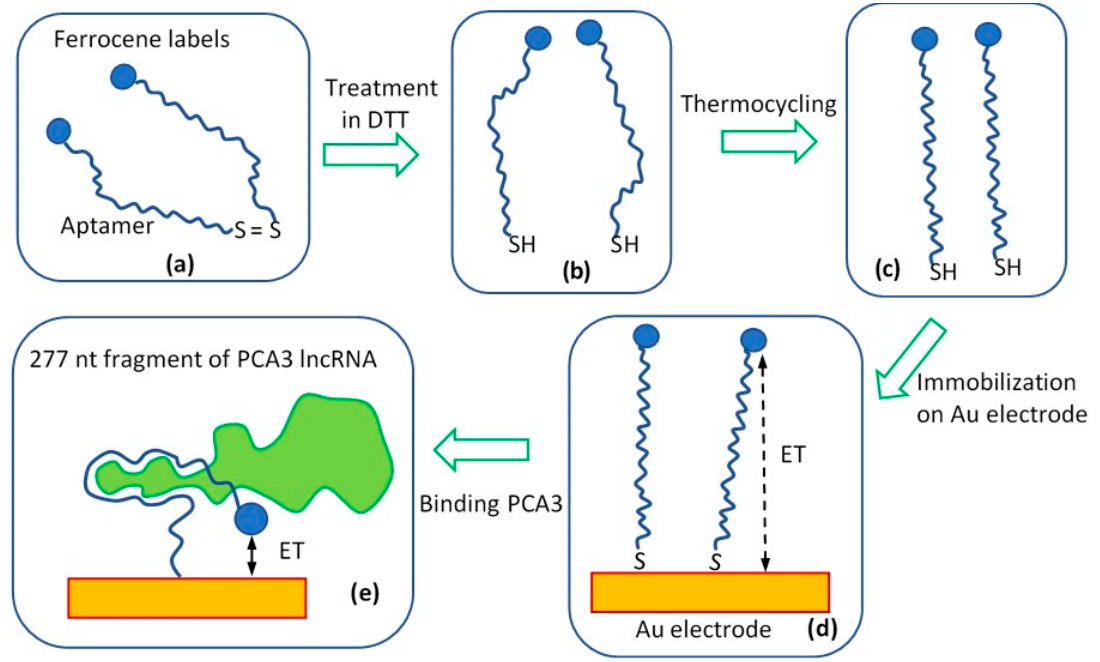
Figure 2. The step-by-step fabrication of aptasensor: ( a ) purchased aptamers; ( b ) aptamers split in HEPES binding buffer containing DTT and MgCl 2 ; ( c ) reactivated aptamers following theromcycling; ( d ) aptamers immobilized on Au electrodes with the 5 ′ redox labels away from the surface ; ( e ) conformational changes of aptamer configuration following PCA3 binding and resulting in a subsequent increase in charge transfer.